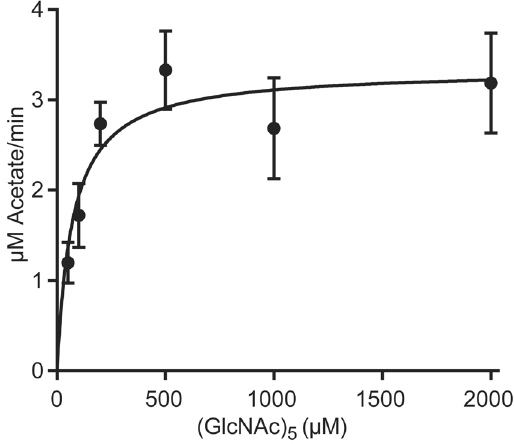
Figure 5. Steady-state kinetics of An CDA with (GlcNAc) 5 . The Figure shows experimental data points with standard deviations and the theoretical fit to these points determined by hyperbolic regression.